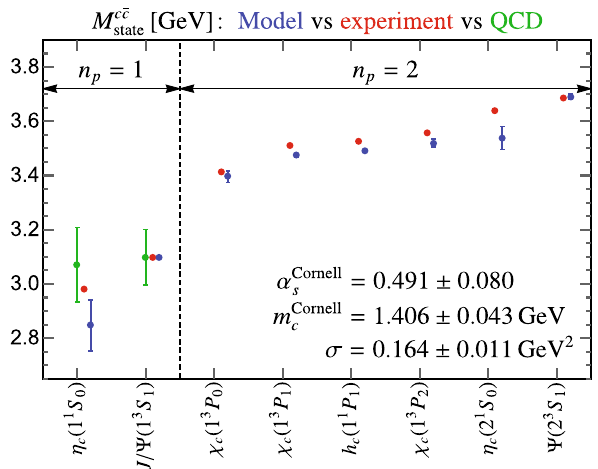
Fig. 5 Same as Fig. 4 for charmonium bound states. Here QCD has been fitted to n p = 1 experimental data, for which non-perturbative effects are quite small, while the Cornell model has been fitted to states with n p ≤ 2